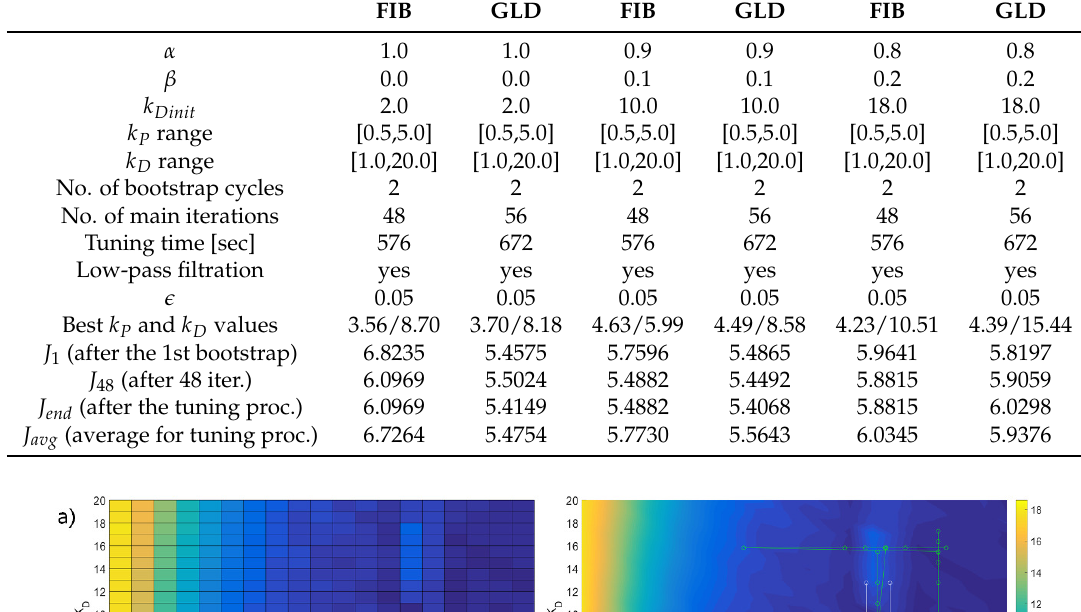
Table 5. Results of simulation experiments.